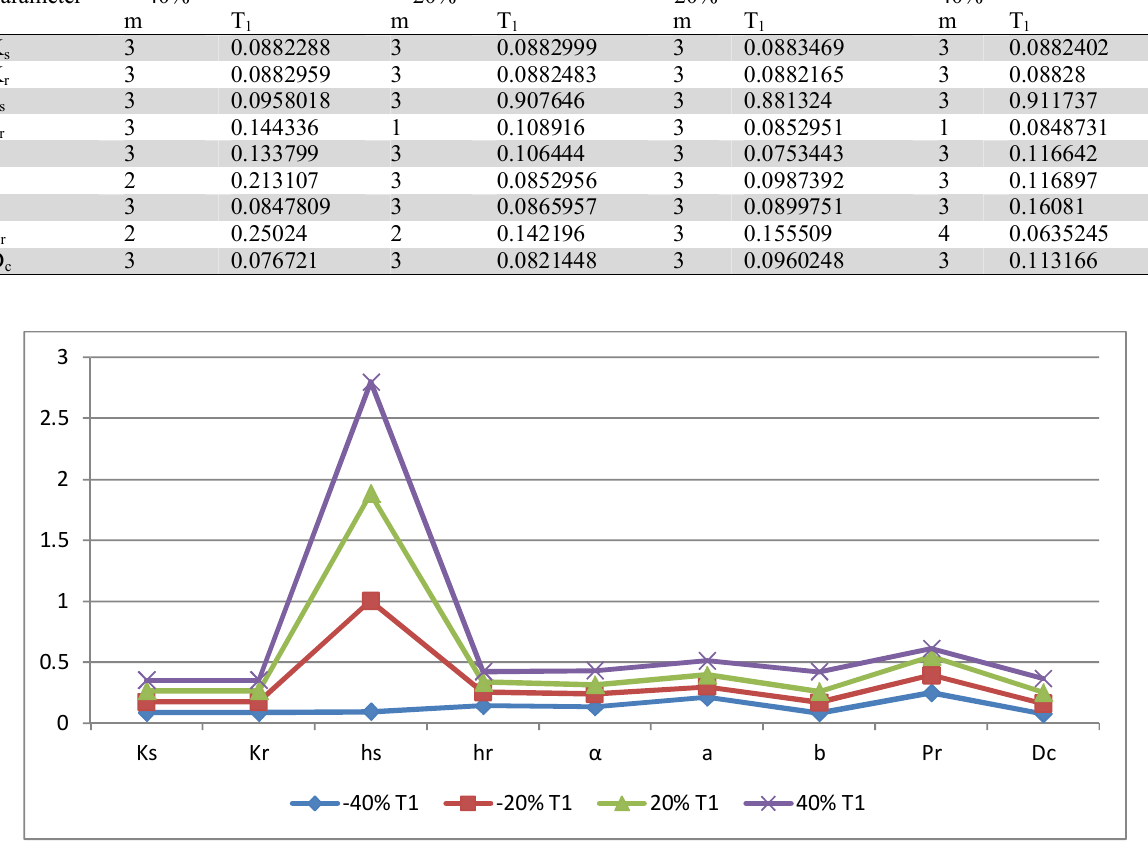
Fig. 4. T Sensitivity Analysis 1